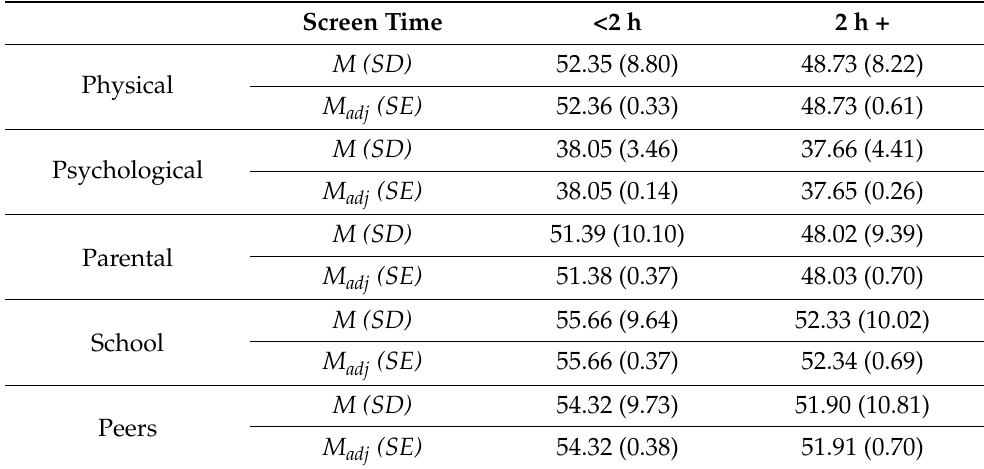
Table 2. Mean and adjusted mean for the five wellbeing dimensions with and above 2-h screen time threshold. One-way MANCOVA.